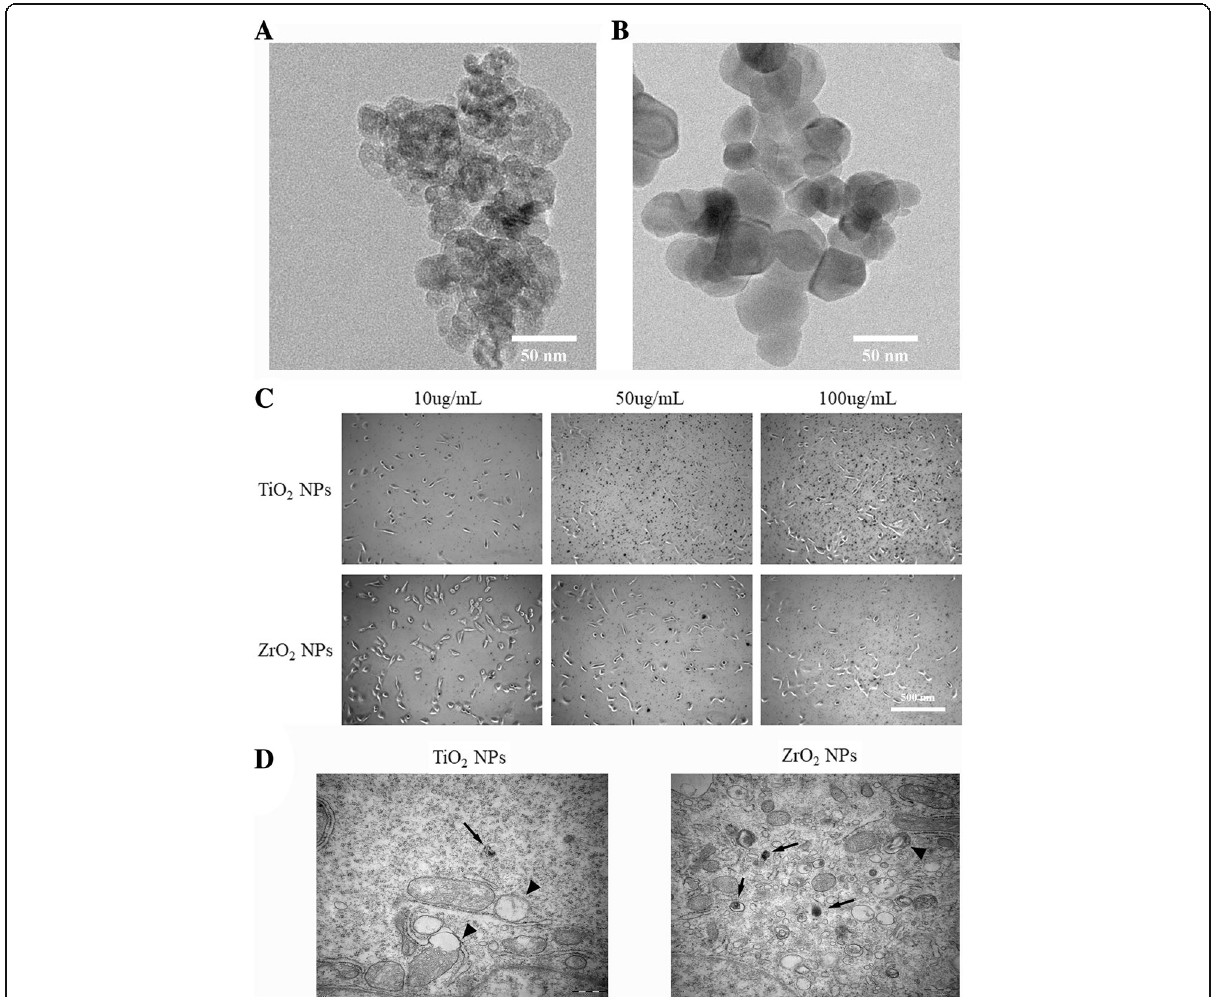
Fig. 1 Characterizations of the TiO 2 and ZrO 2 NPs. TiO 2 ( a ) and ZrO 2 ( b ) NP morphology and size were detected using TEM. ( c ) The co-culture situation of 3T3 cells and nanomaterials was observed after TiO 2 and ZrO 2 NP treatment concentrations of 10, 50, and 100 μ g/mL. ( d ) The TEM results were obtained after TiO 2 and ZrO 2 NP treatment for 1 h